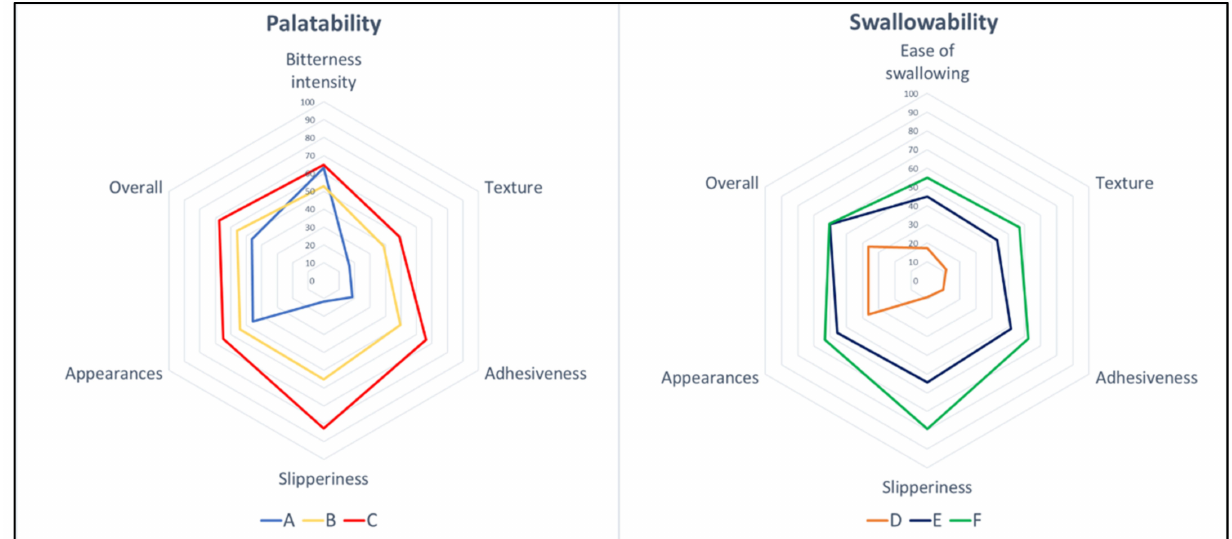
Figure 4. Radar charts for bitterness intensity/ease of swallowing, texture, adhesiveness, slipperiness, appearance, and overall, for fluid gels. Each sensory item is described by its population mean for the 100 mm visual analogue scale (VAS), where 0 is the lowest possible intensity of the stimulus, and 100 is the